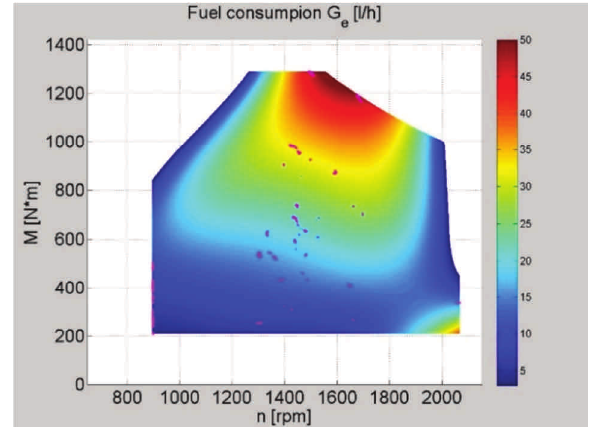
Fig. 9. Characteristics obtained from operational data: static state duration 4 s; derivative limits: 5 N ∙ m/s, 5 rpm/s